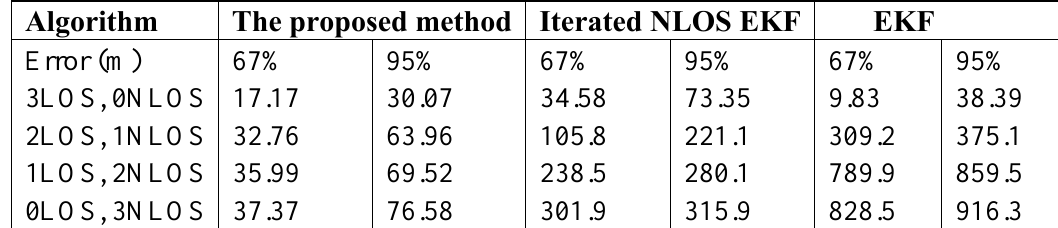
Table 1. Performance comparisons among three algorithms under the different NLOS conditions.